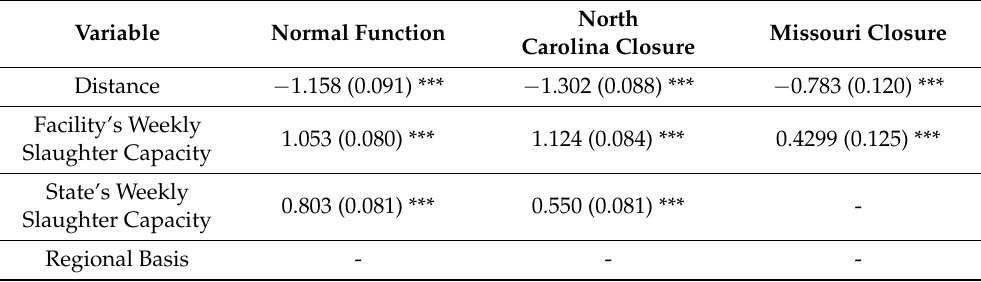
Table 1. Results of the fitted PPML models for all three scenarios. Results reported as regression coefficient (Standard Error), p < 0.001